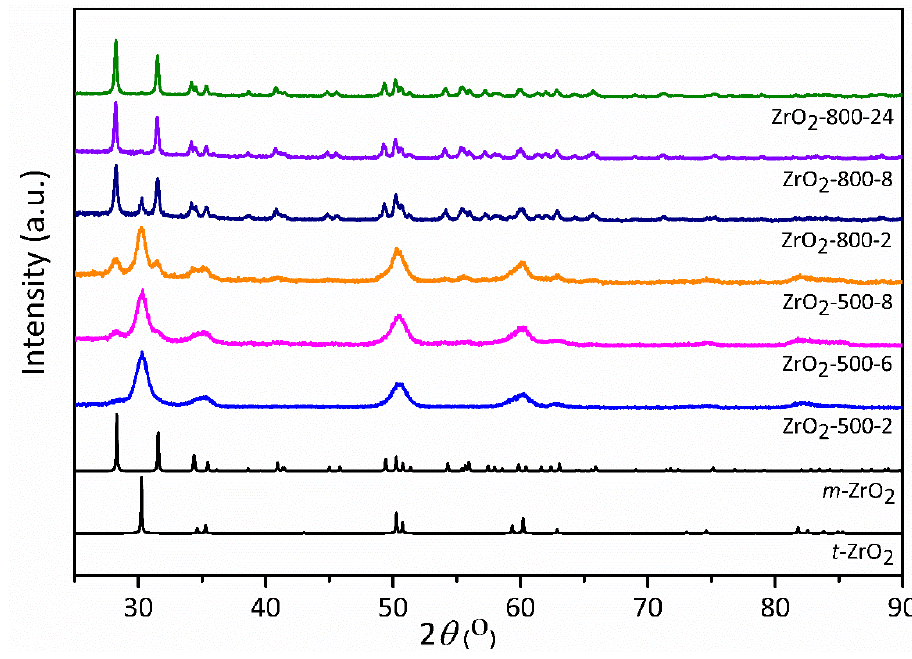
Figure 1. PXRD patterns of ZrO 2 at different calcination temperatures and times. Table 1. Phase ratio of ZrO 2